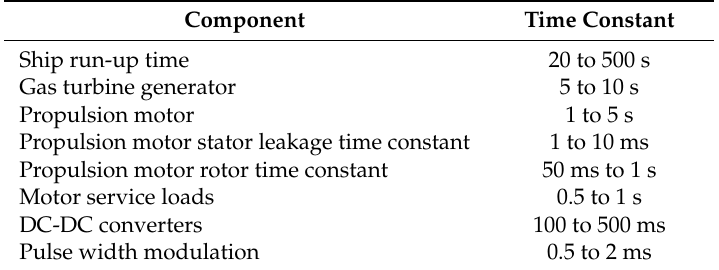
Table 1. Time constants of different components of a marine electric power system